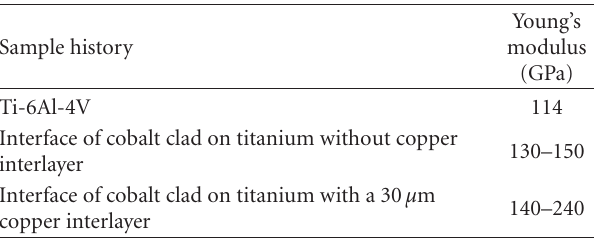
Table 1: Summary of Young’s Modulus of as-received Ti-6Al-4V and direct laser clad Co on Ti-6Al-4V without any interlayer and with a 30 μ m copper